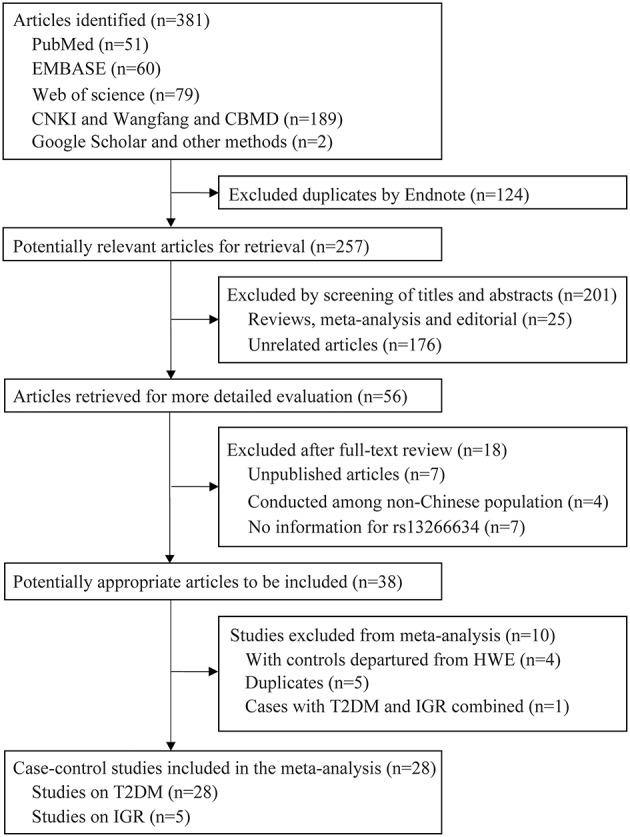
Flow chart for the selection of included studies.